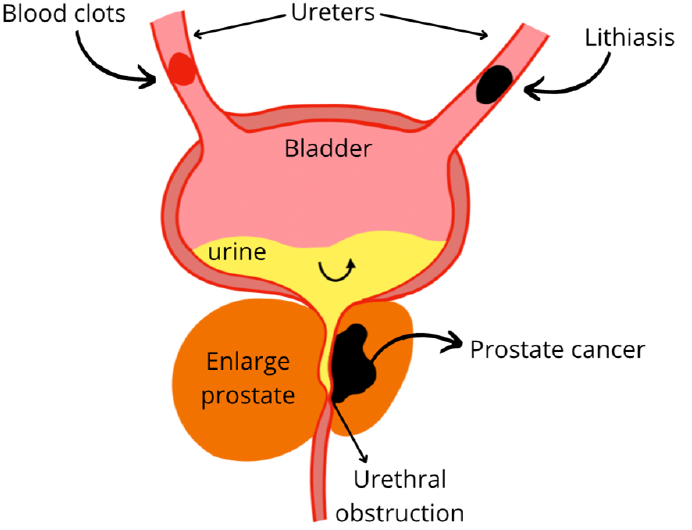
Figure 7. Urinary flow obstruction due to lithiasis, blood clots, or prostate enlargement.